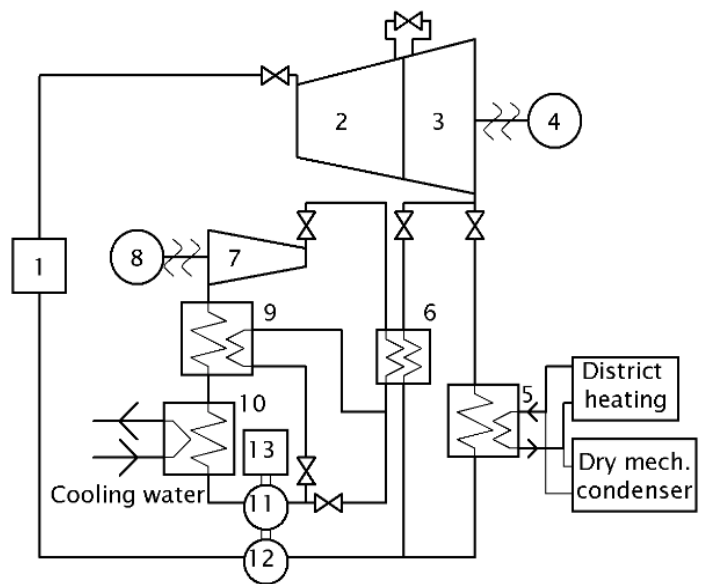
Figure 9. Assumed innovative topology with implementation of the ORC to the original BPT cycle.